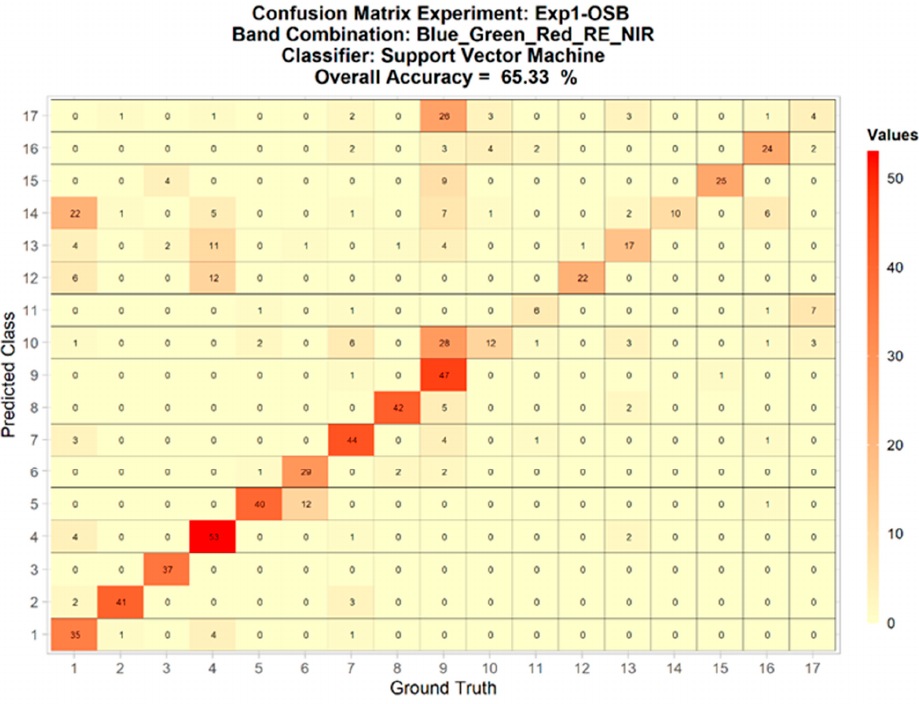
Figure A11. Confusion matrix for the best results obtained in Exp1-OSB, using the Support Vector Machine classifier (the Blue_Green_Red_RE_NIR band combination).